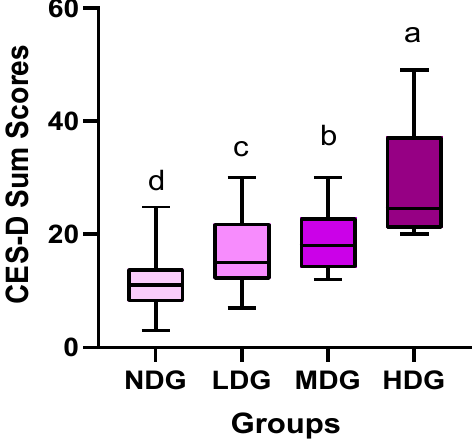
Figure 4. Comparative results of CES-D sum scores among four groups. Symbols a , b , c , and d represent post hoc results from Bonferroni test.